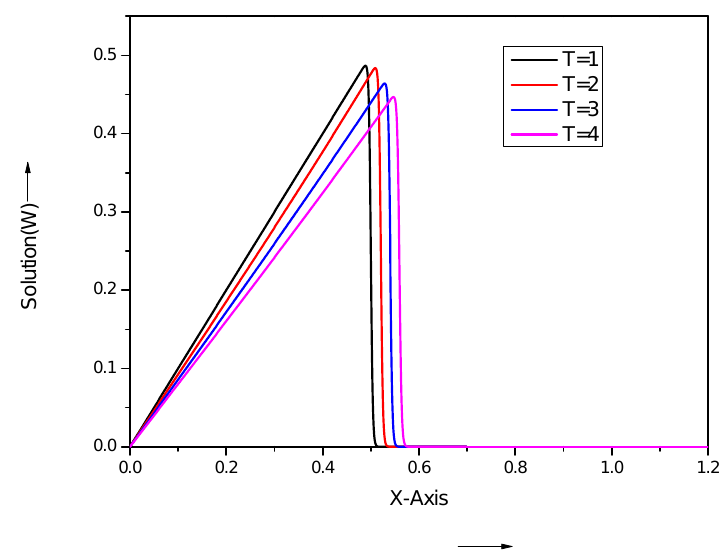
Figure 11. Numerical results by present method with ∆ x = 0.001, ν d = 0.001 and τ = 0.01 at different times T for problem 5.3.